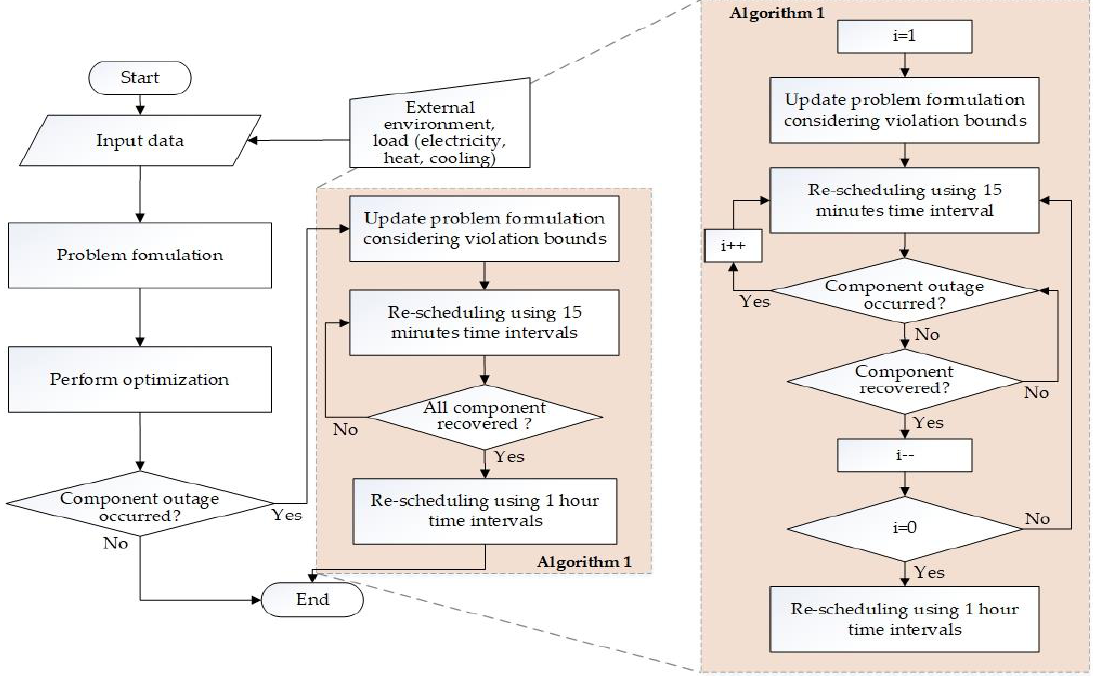
Figure 2. Flowchart of the energy scheduling algorithm for a building microgrid with rooftop greenhouse in islanded mode.